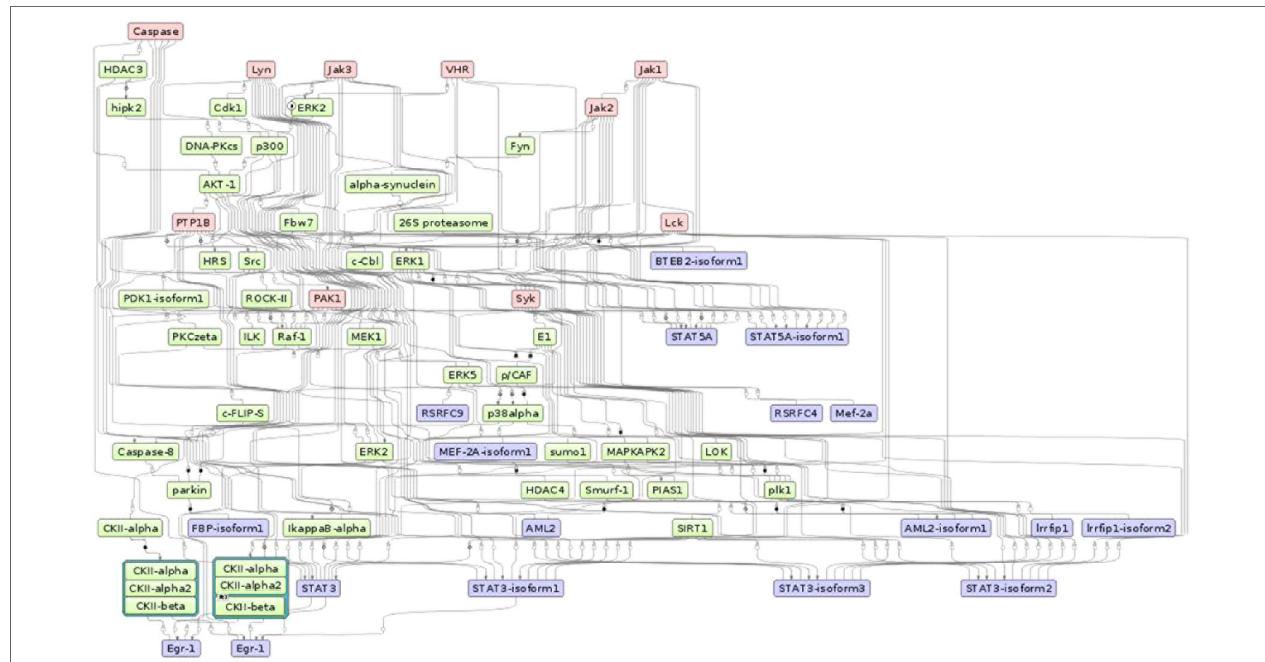
FIGURe 7 | The master regulatory networks for Sheko (Caspase, Lyn, Jak1, Jak2, Jak3, VHR, PTP1B, PAK1, Lck, and Syk). Red, blue, and green indicate master regulators, regulated proteins, and connecting molecules, respectively.